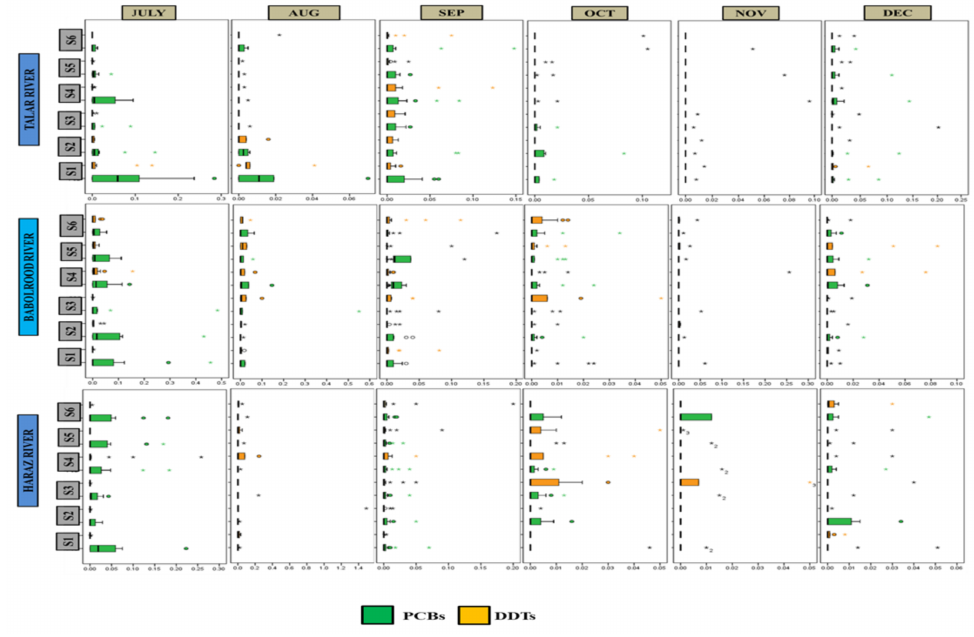
Figure 4. Monthly variations of legacy POPs (PCBs and DDRs) in ng / L for all stations from three rivers of Iran, viz. Talar, Babolrood and Haraz